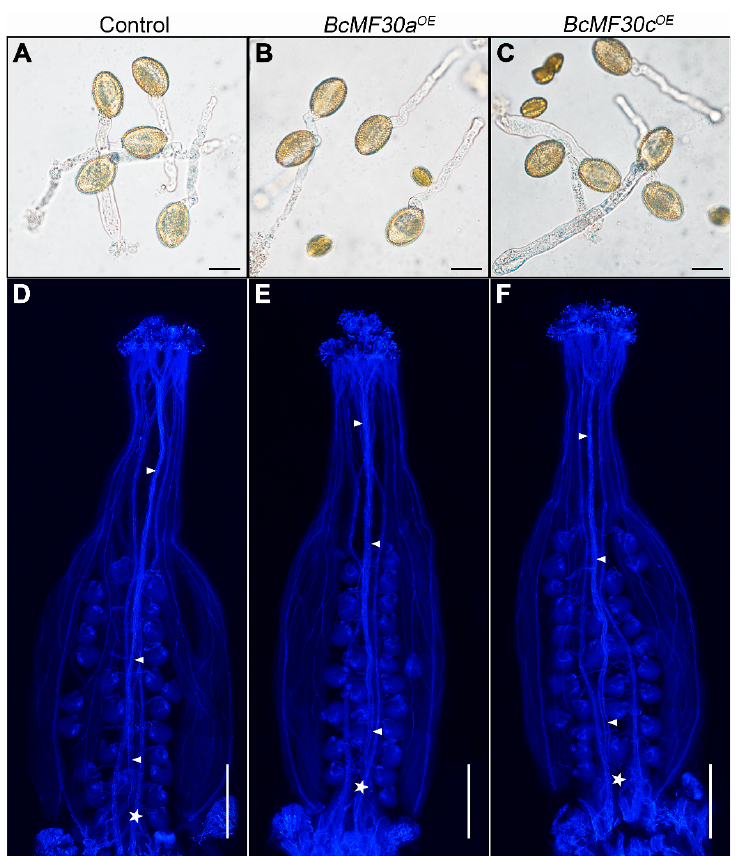
Figure 6. The in vitro and in vivo pollen germination tests of BcMF30a OE and BcMF30c OE transgenic plants. ( A – C ) The in vitro pollen germination test. ( D – F ) The in vivo pollen germination and pollen tube growth. The arrows indicate the pollen tubes, and the asterisks indicate the end position of pollen tubes. Bars = 20 μ m in ( A – C ); 100 μ m in ( D – F ).